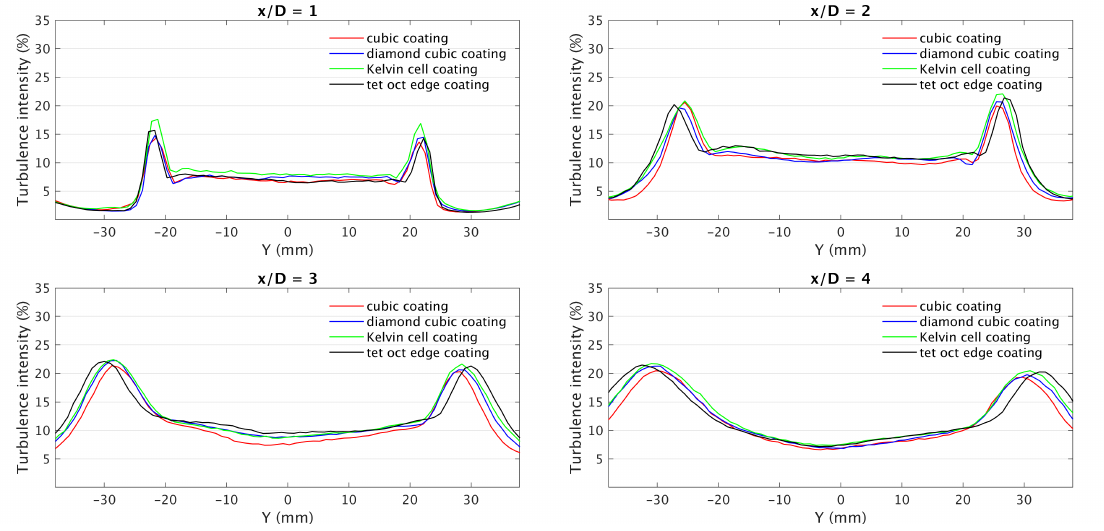
Figure 20. Turbulence intensity graph for cylinders 16 and